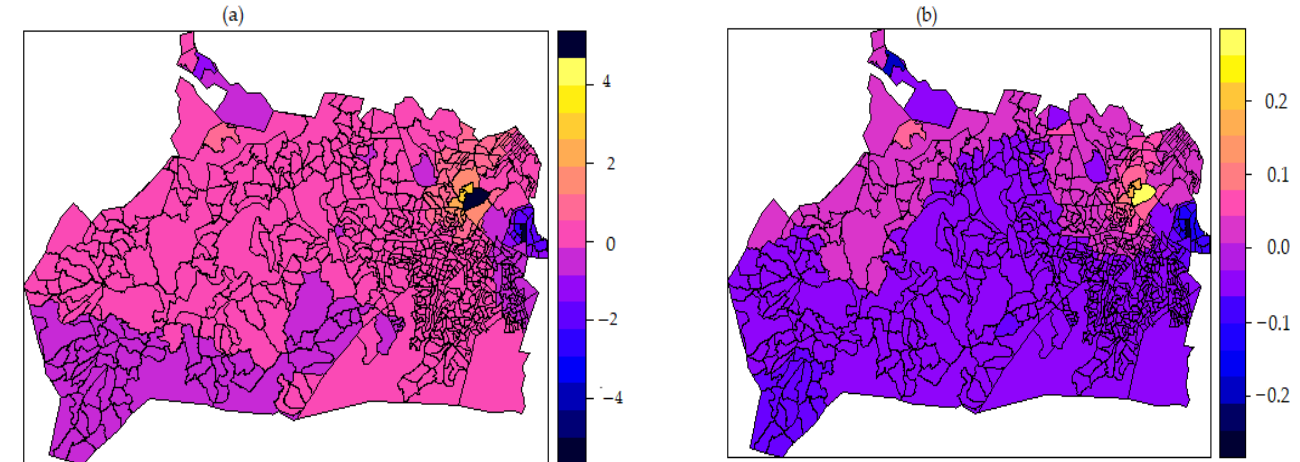
Figure 4. Map of estimated posterior mean for ( a ) structured and ( b ) unstructured spatial effect on the log-odds of unsuppressed HIV viral load among HIV-positive men and women in rural Vulindlela and peri-urban Greater Edendale areas in uMgungundlovu District, KwaZulu-Natal Province, South Africa.